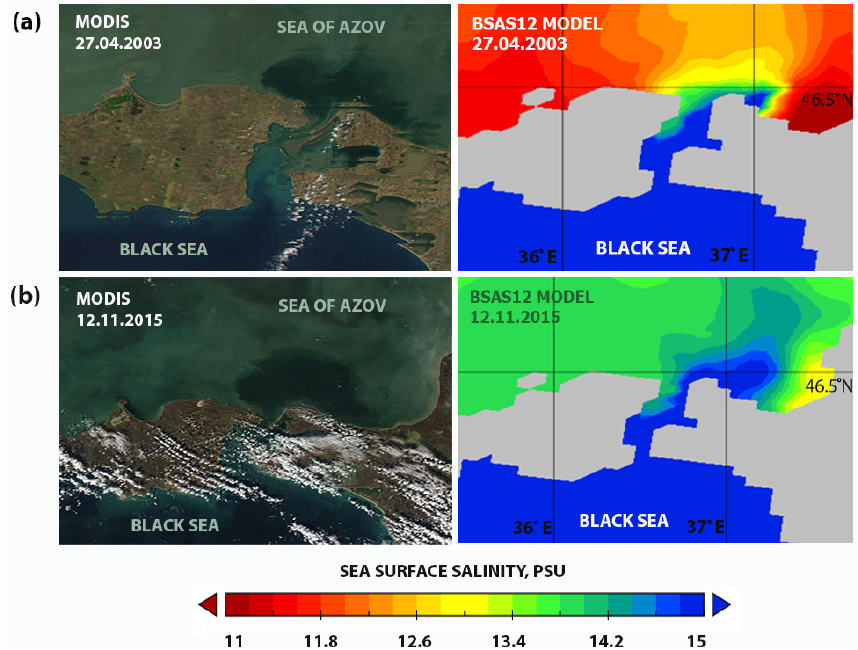
Figure 10. Formation of the BP after the wind relaxation on (a) 27 April 2003 and (b) 12 November 2015; retrieved from MODIS satellite data and confirmed by the BSAS12 model